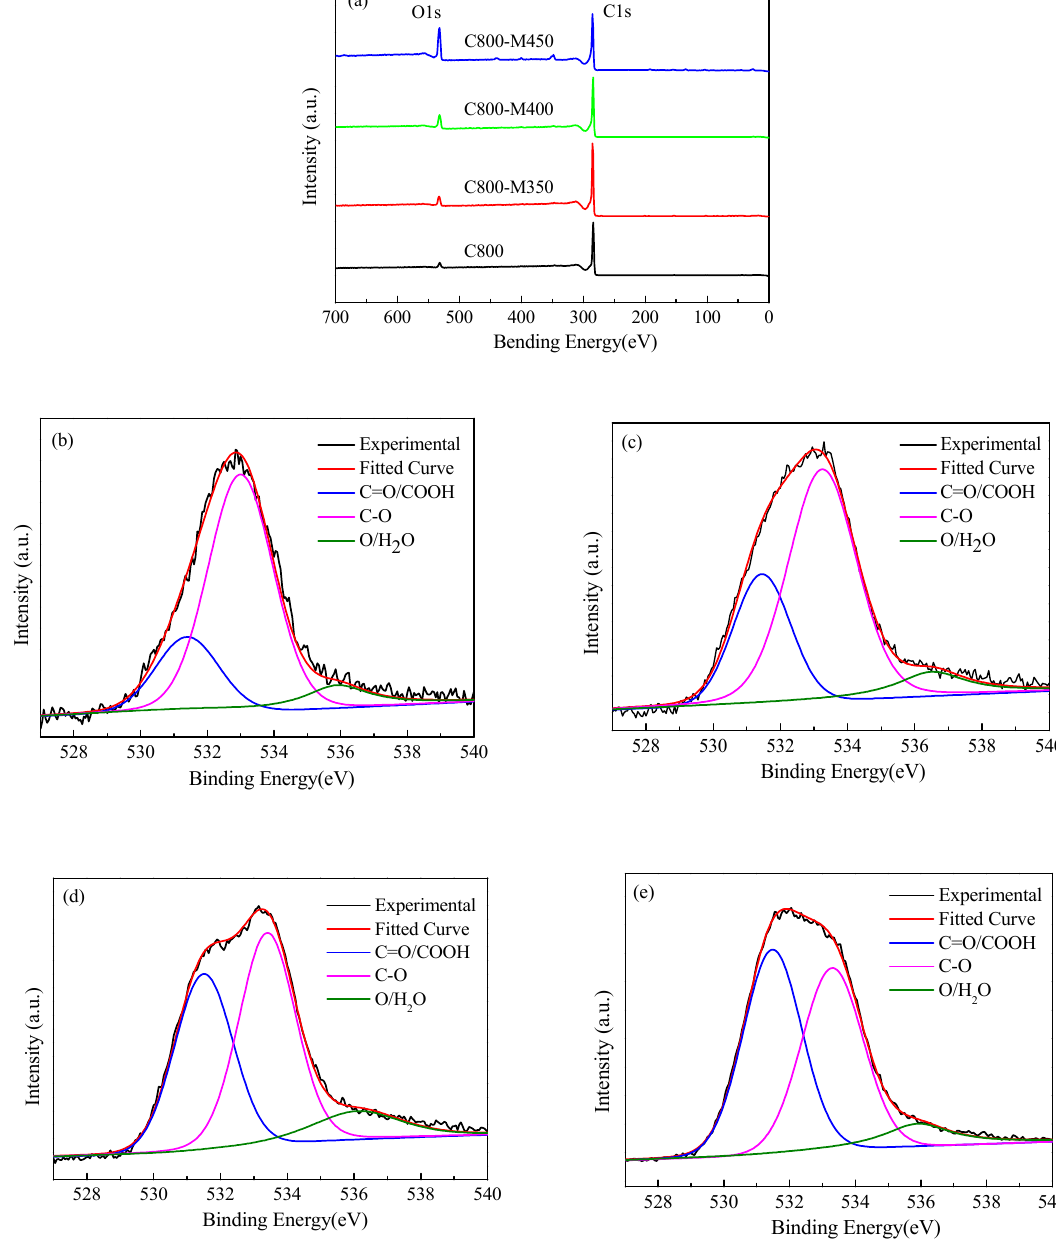
Figure 6. X-ray photoelectron spectroscopy (XPS) spectra of the wood-derived porous carbons materials: ( a ) survey spectra and high-resolution O1s spectra, ( b ) C800, ( c ) C800-M350, ( d ) C800-M400, ( e ) C800-M450. Table 2. Carbon and oxygen content determined by XPS data and results of the curve-fitting of the high-resolution XPS spectra for the O 1s region.